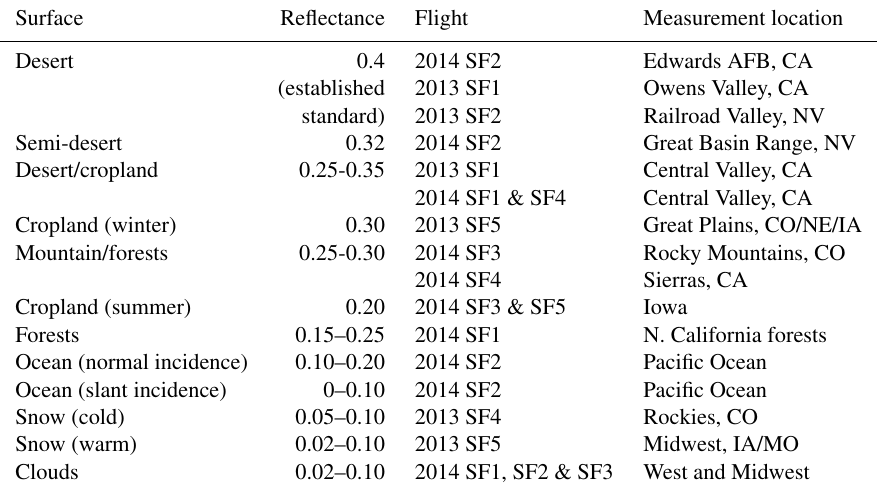
Figure 6. (a) shows the cumulus clouds in the PBL from the ASCENDS sunset flight on 25 August 2014 near the West Branch, Iowa, tall tower. (b) shows the returned pulse energy in number of photons as a function of lidar range from aircraft altitude for the cumulus clouds. The average ground reflectance (in green) is approximately 20%, while the average cumulus cloud top reflectance is about 5% (in blue) and shows more variability. Table 1. Lidar measurements of surface reflectance during the 2013 and 2014 ASCENDS science flights (SF) over a variety of surface types, including ocean, snow and clouds. Reflectance of 0.4 over desert was specified as a standard to quantify reflectance over other surface